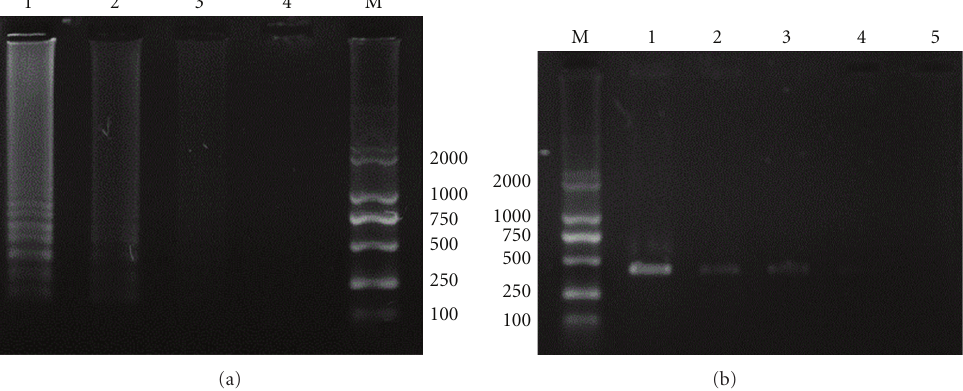
Figure 4: (a) Comparative sensitivity of LAMP and PCR (sensitivity of LAMP). M: DL2000 DNA marker; 1: 10 3 CFU/mL; 2: 10 2 CFU/mL; 3: 10 CFU/mL; 4: negative control. (b) Comparative sensitivity of LAMP and PCR (sensitivity of PCR). M: DL2000 DNA marker; 1: 10 6 CFU/mL; 2: 10 5 CFU/mL; 3: 10 4 CFU/mL; 4: 10 3 CFU/mL; 5: 10 2